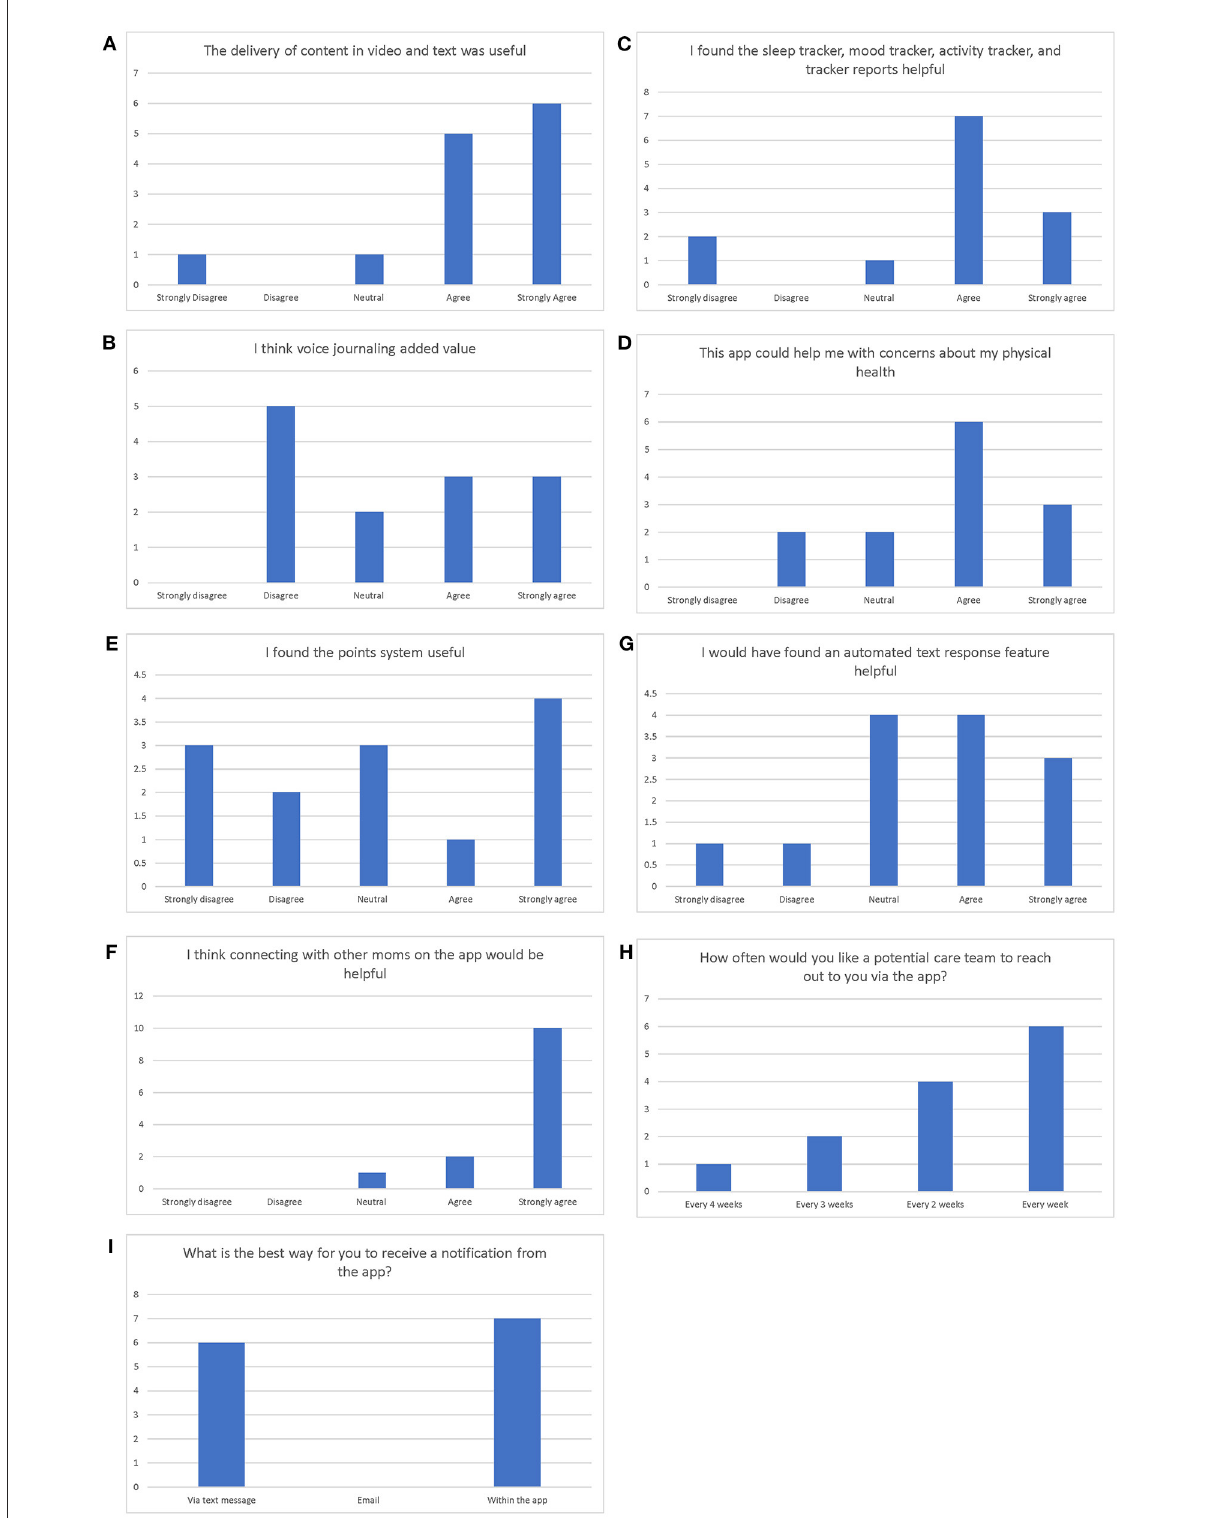
FIGURE5 (A–I) Results of the user experience